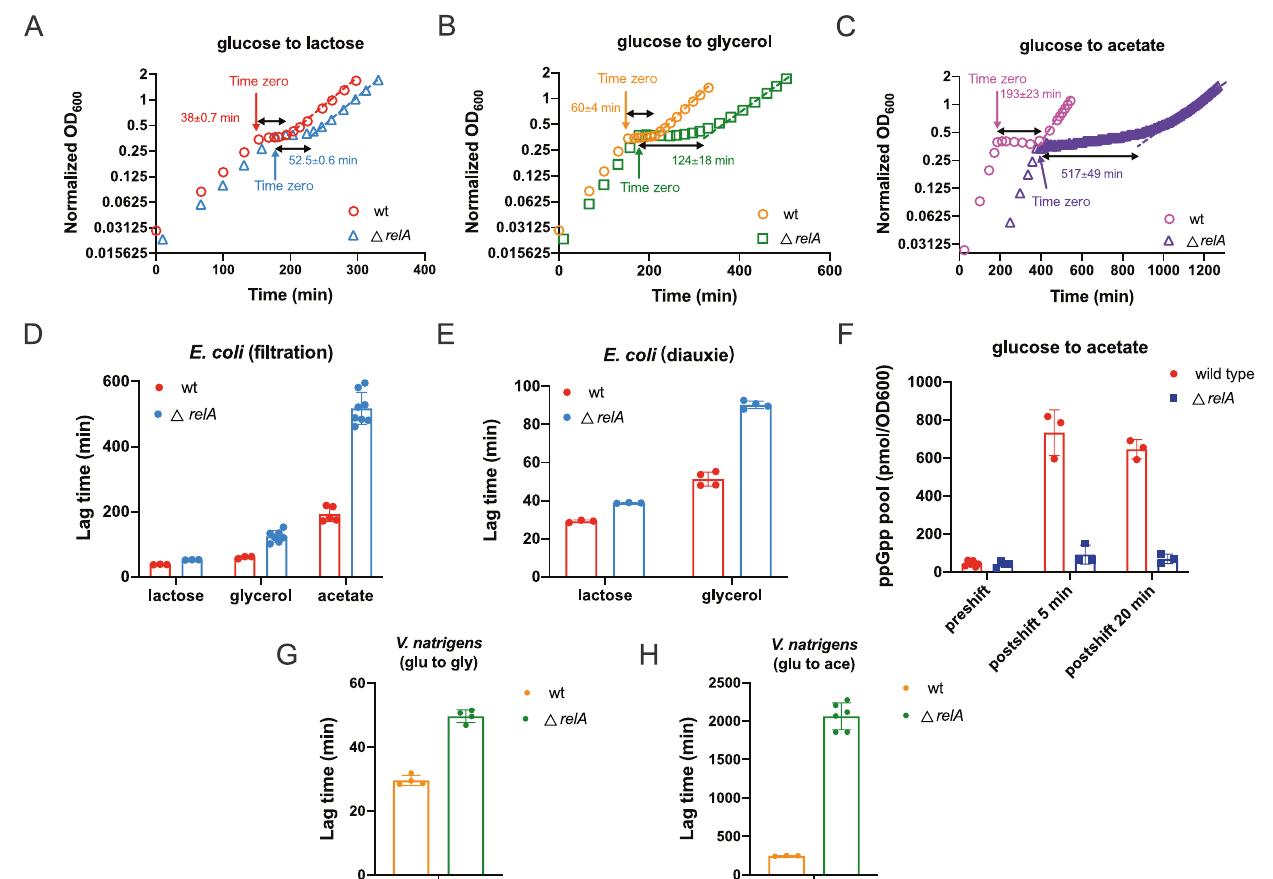
Fig. 5 | Growth curve and lag time of E. coli and V. natriegens during carbon downshift. A Growth and lag of E. coli wild type and relA -de fi cient strains during transitionfromglucosemediumtolactosemedium. B Growthandlagof E.coli wild type and relA -de fi cient strains during transition from glucose medium to glycerol medium. C Growth and lag of E. coli wild type and relA -de fi cient strains during transition from glucose medium to acetate medium. D Lag time of E. coli during carbondownshiftusing fi ltrationmethod.Errorbarsarethestandarddeviationsof several biological replicates (wild type strain: n =3, 3, and 5 for lactose, glycerol, and acetate, respectively; relA -de fi cient strains: n =3,7, and 8 for lactose,glycerol, and acetate, respectively). E Lag time of E. coli during carbon diauxie, in which the secondary carbon source (lactose or glycerol) is supplemented together with